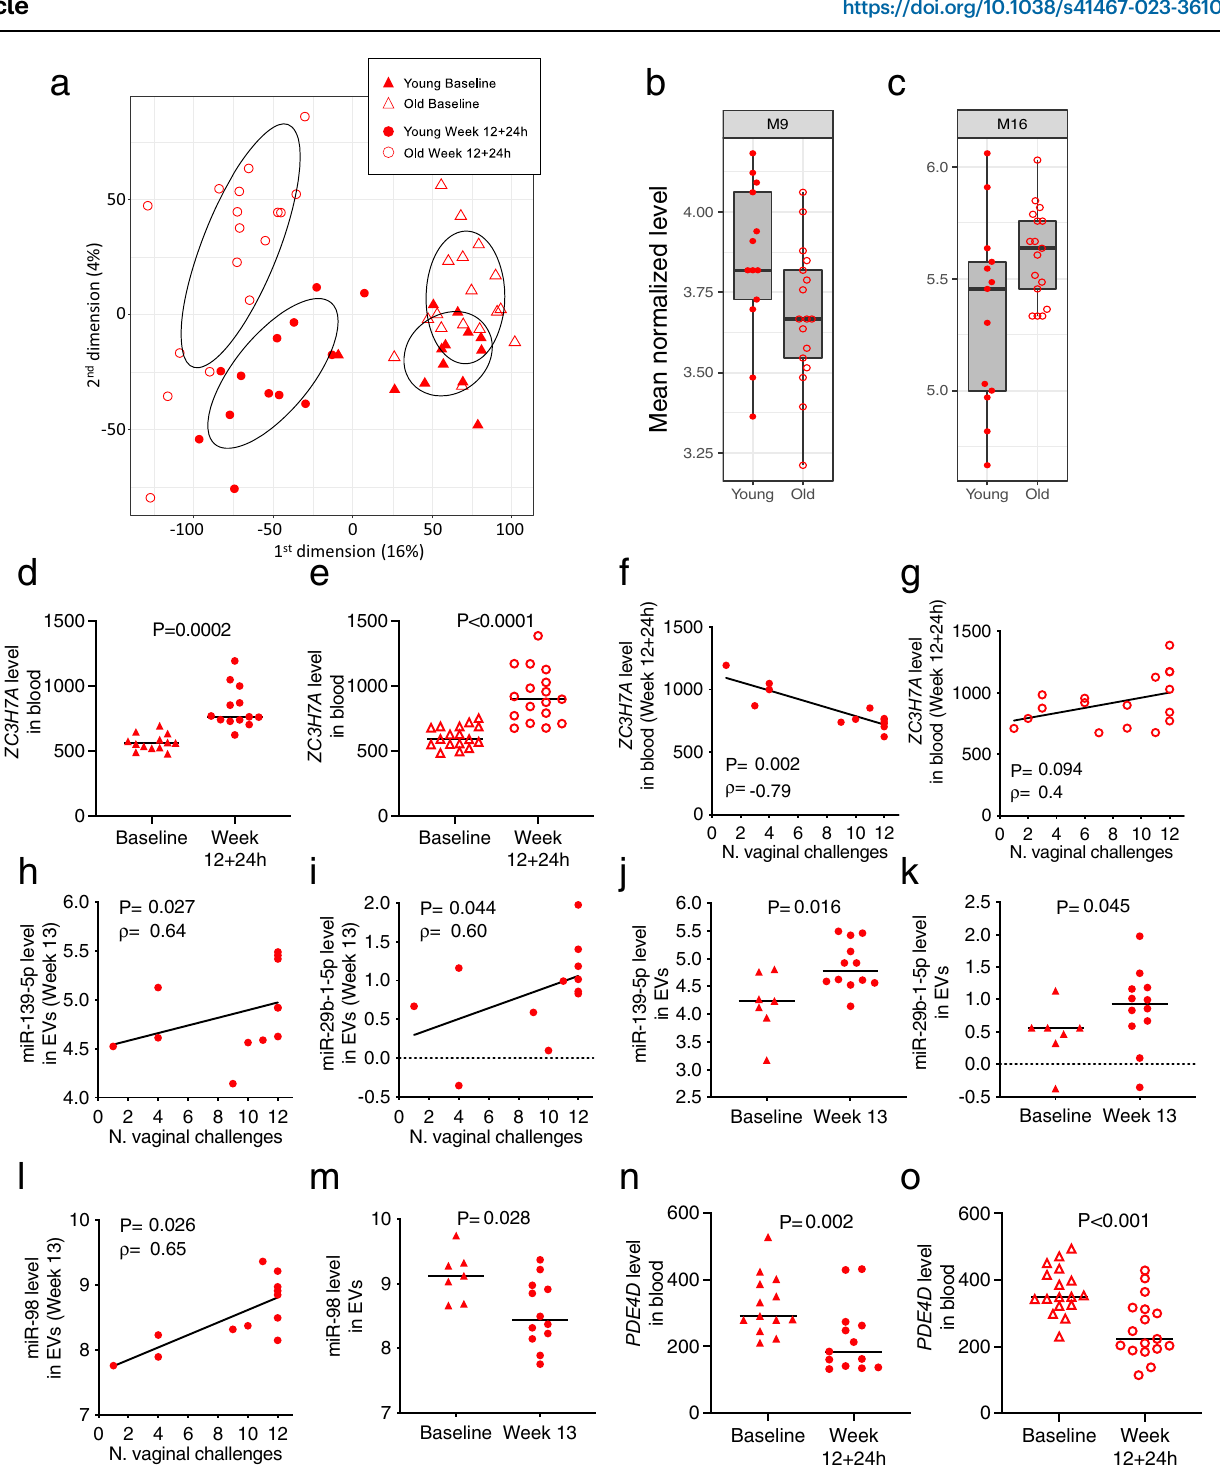
are displayed. d , e Expression of ZC3H7A gene at baseline and 24h following vac- cinationin( d ) n =13youngand( e ; p =0.00003) n =17oldanimals. f , g